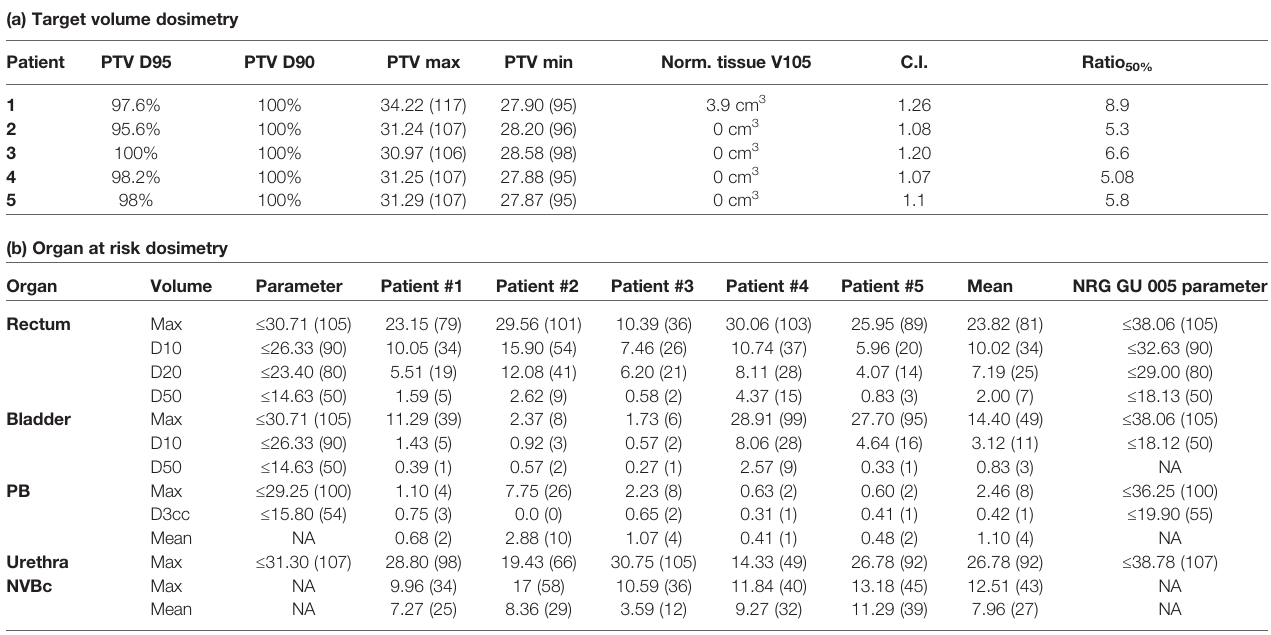
TABLE 3 | f-SBRT dosimetry; Gy (% of prescription